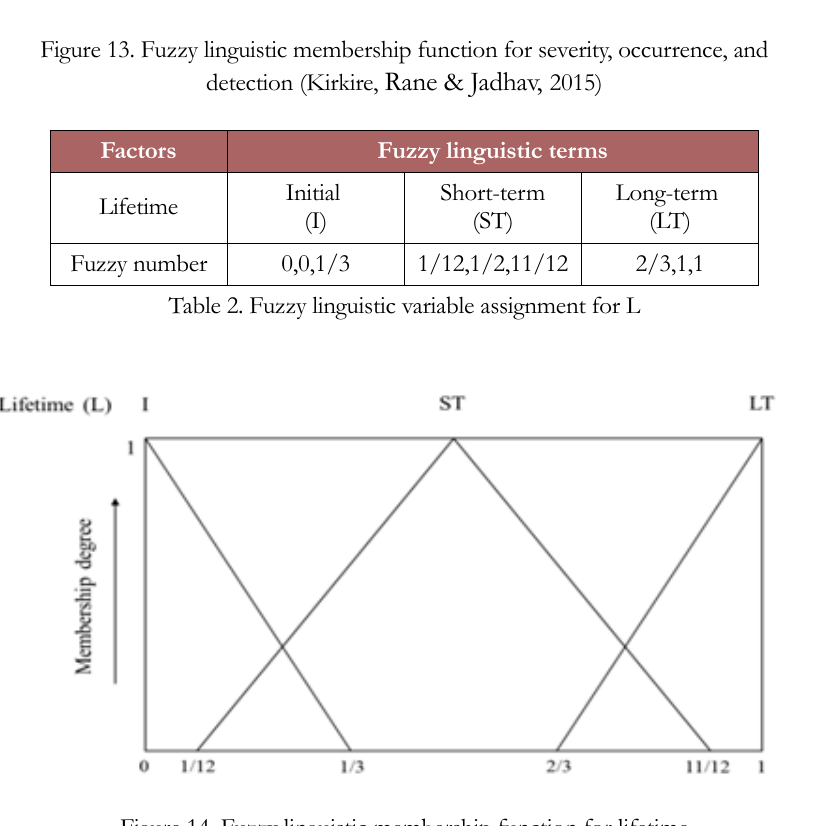
Figure 14. Fuzzy linguistic membership function for